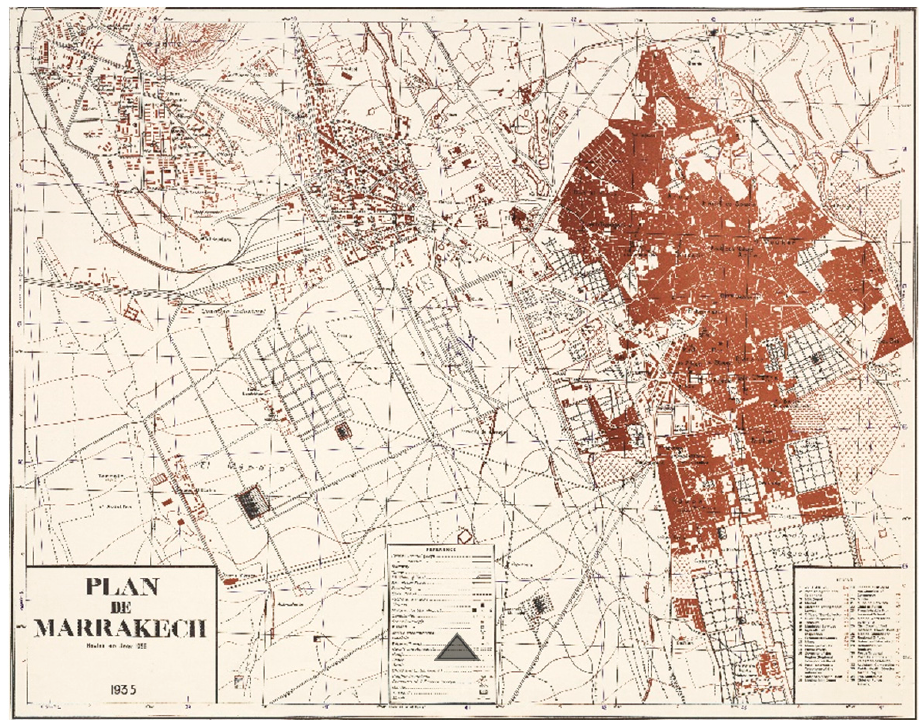
Figure 9. Map showing the contrasts between the Medina and the Colonial urban tissues, Marrakesh in 1924 (data source: https://thehouseinmarrakech.wordpress.com (accessed on 25 March 2020)).